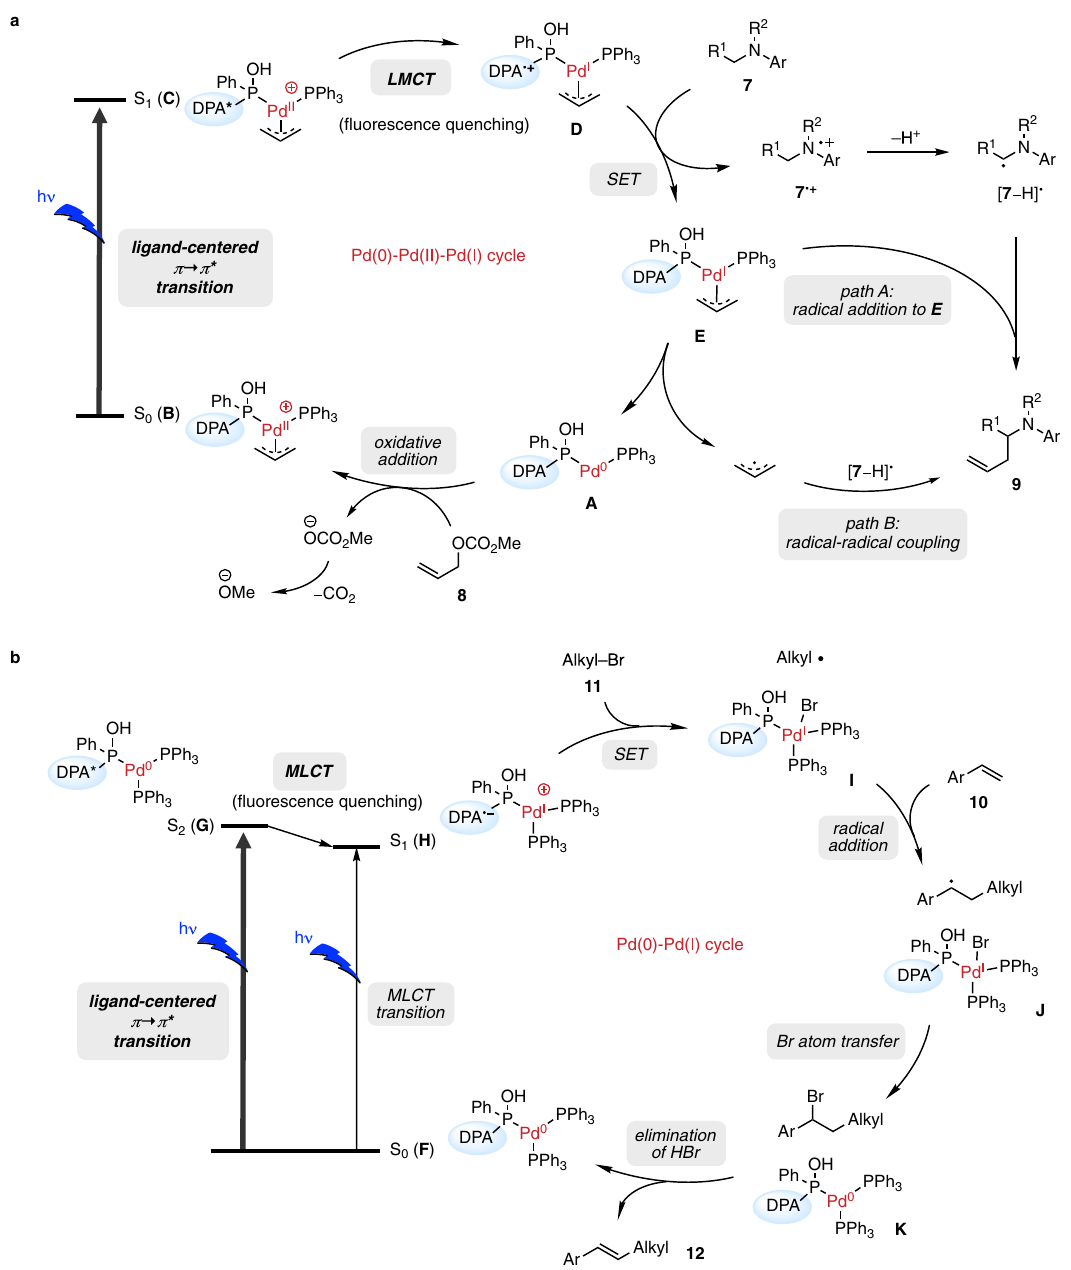
Fig. 6 Proposed reaction mechanisms of Pd-catalyzed radical cross-couplings. a Pd-catalyzed α -allylation of amines. b Pd-catalyzed photo-Heck reaction. DPA 9,10-diphenylanthracene, LMCT ligand-to-metal charge transfer, SET single electron transfer, MLCT metal-to-ligand charge